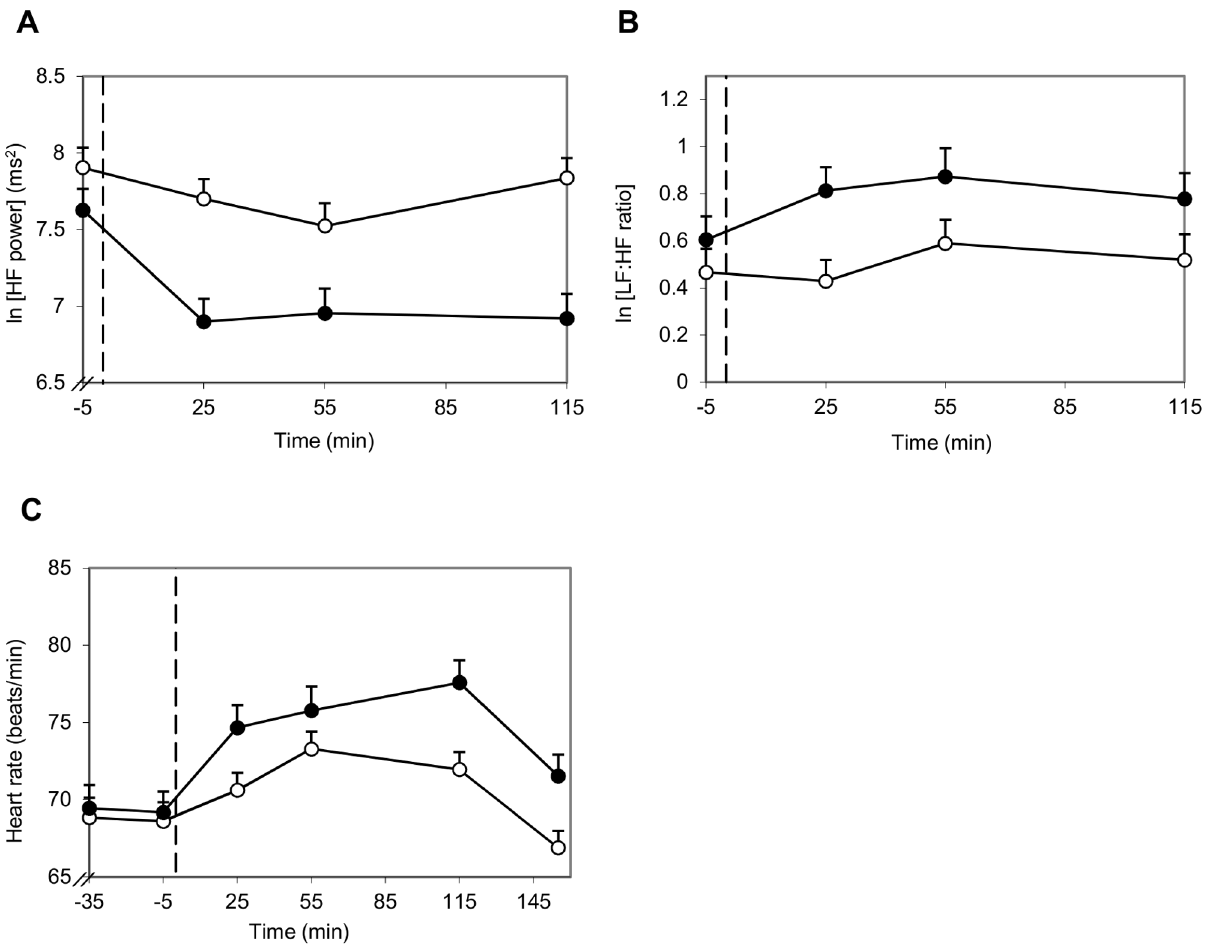
N 2 Alcohol; - - start alcohol